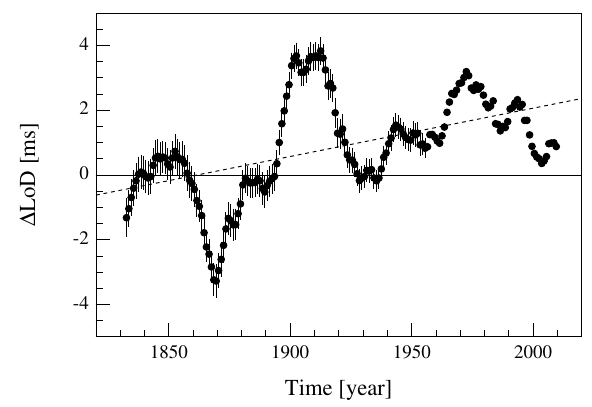
Fig. 1. Values and uncertainties for the excess length of day, ∆ LoD , spanning 1832.5-2009.5 at 1-year intervals.